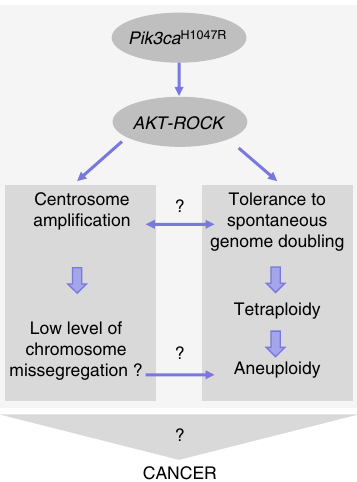
Fig. 9 Summary of key observations on the impact of PIK3CA mutation on centrosome ampli fi cation and possible tolerance to